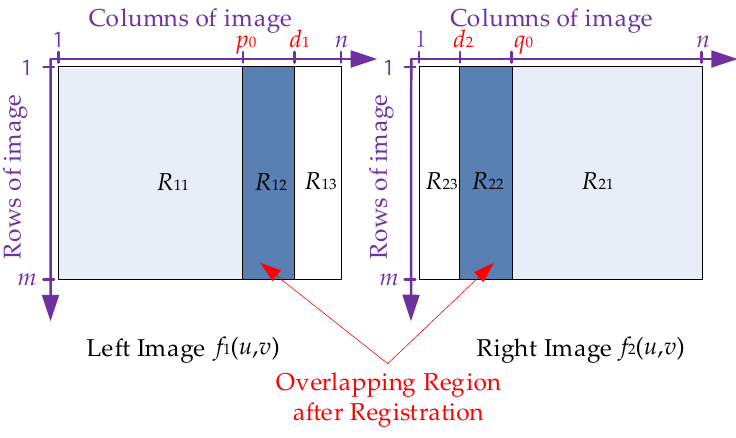
Figure 5. Determining the extent of the overlapping region.